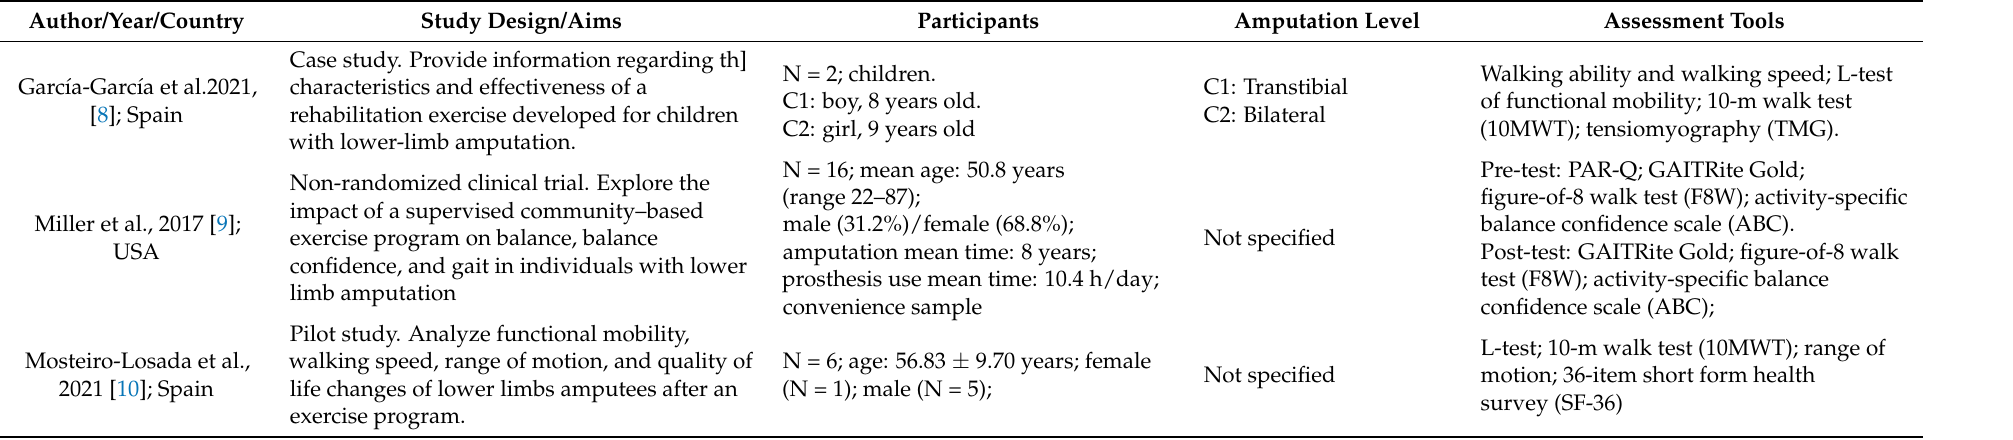
Table 4. Study characteristics.